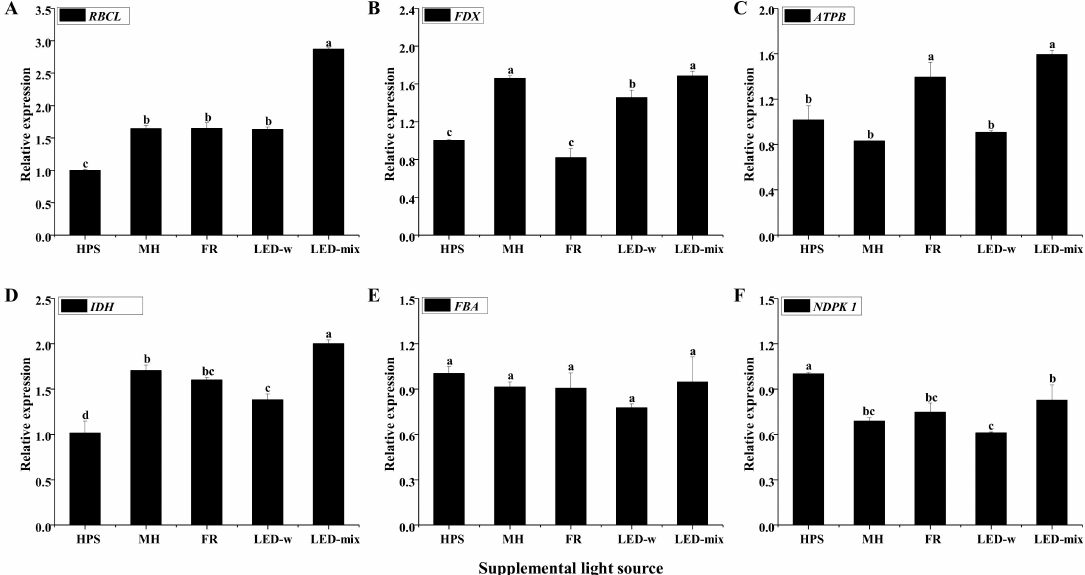
Figure 6. The relative gene expression of ribulose bisphosphate carboxylase large chain (RBCL) ( A ), ferredoxin (FDX) ( B ), ATP synthase subunit β (ATPB) ( C ), isocitrate dehydrogenase (IDH) ( D ), fructose-bisphosphate aldolase (FBA) ( E ), and nucleoside diphosphate kinase 1 (NDPK 1) ( F ). Different small letters indicate the significant separation within treatments by Duncan’s multiple range test at a 0.05